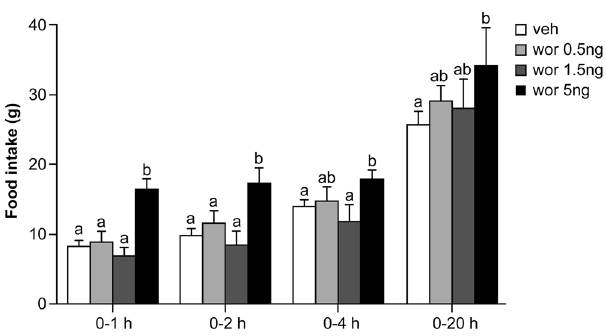
Figure 1. Food intake at 1, 2, 4, and 20 h after third ICV administration of different doses of wortmannin or vehicle. Food intake did not significantly increase in response to 0.5 ng or 1.5 ng wortmannin, but increased in response to 5 ng wortmannin. Data are represented as mean ± SEM (N = 4 for each group). In each panel, groups that share the same letter (eg. “a” and “ab”) are not significantly different from each other after obtaining a significant main effect by two-way